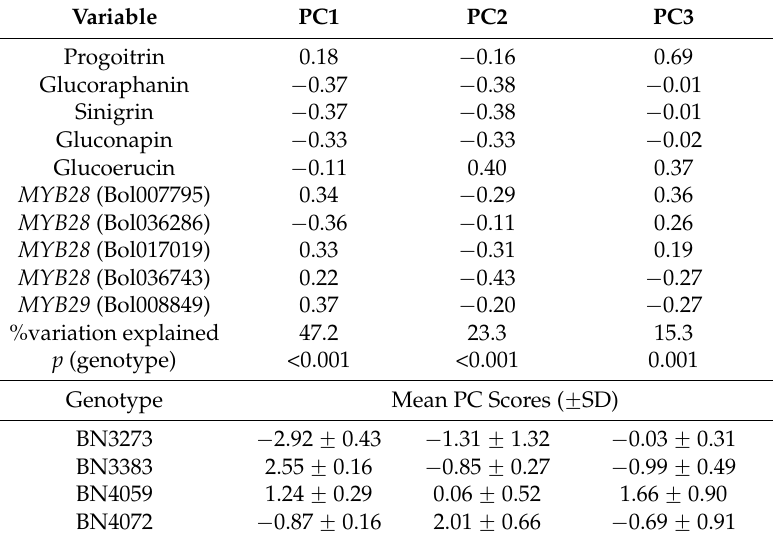
Table 1. Principal component analysis for aliphatic glucosinolate contents and the relative expression level of transcription factor-related genes in four cabbage lines of B. oleracea. PC, principal component; p , statistical significance; SD, standard deviation.